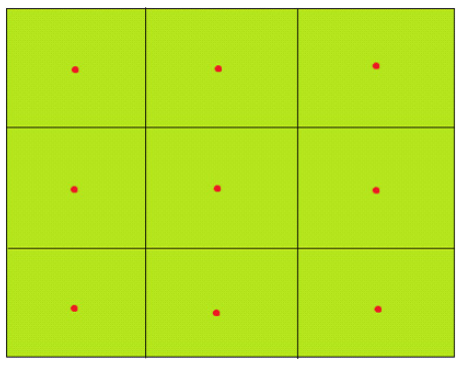
Fig. 3. Diagrammatic sketch of 3 (cid:1) 3 array scanning region.